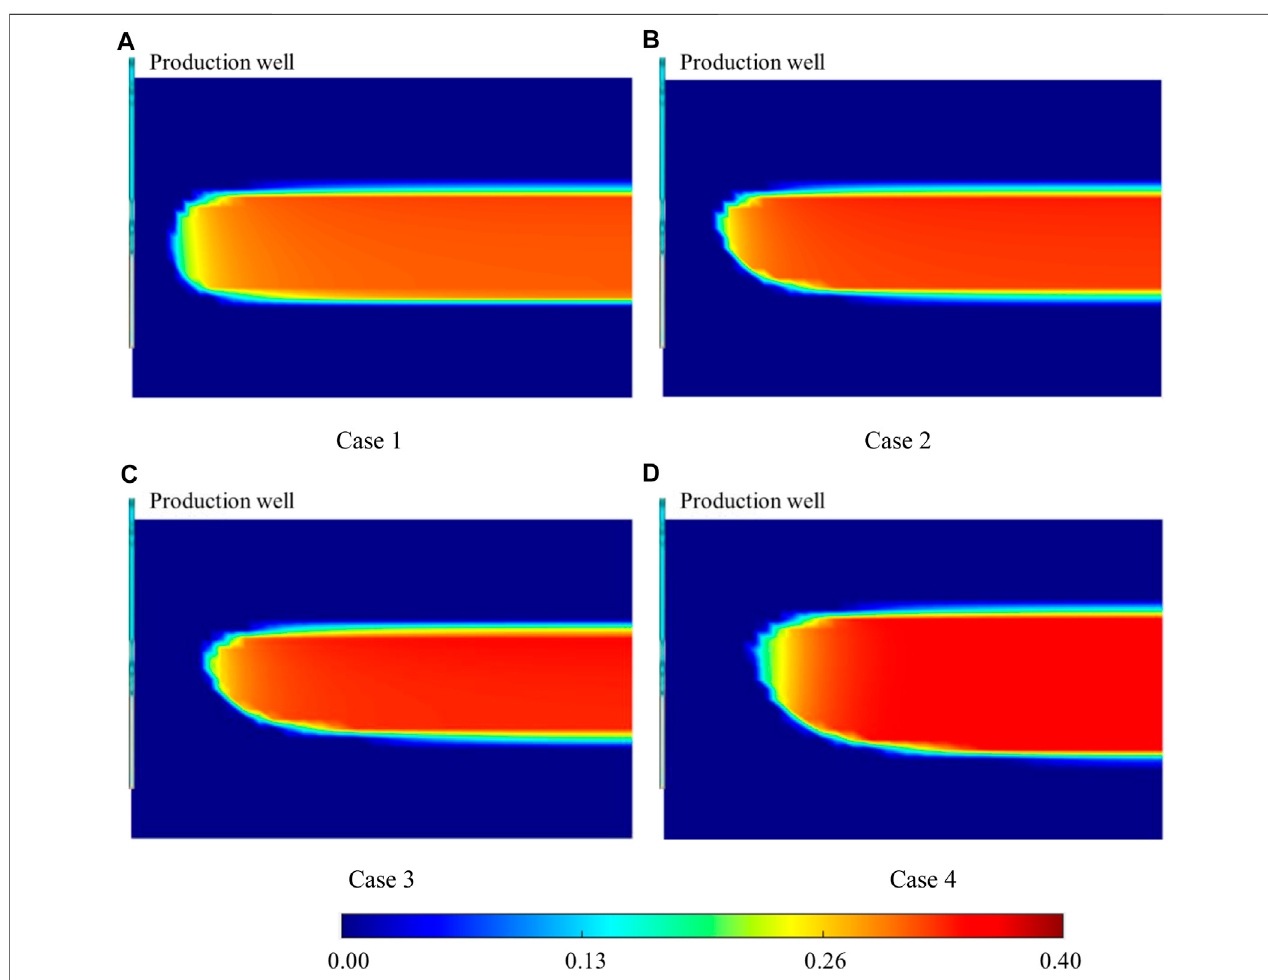
FIGURE 12 | Hydrate saturation distribution of each case. (A) Case 1. (B) Case 2. (C) Case 3. (D) Case 4.